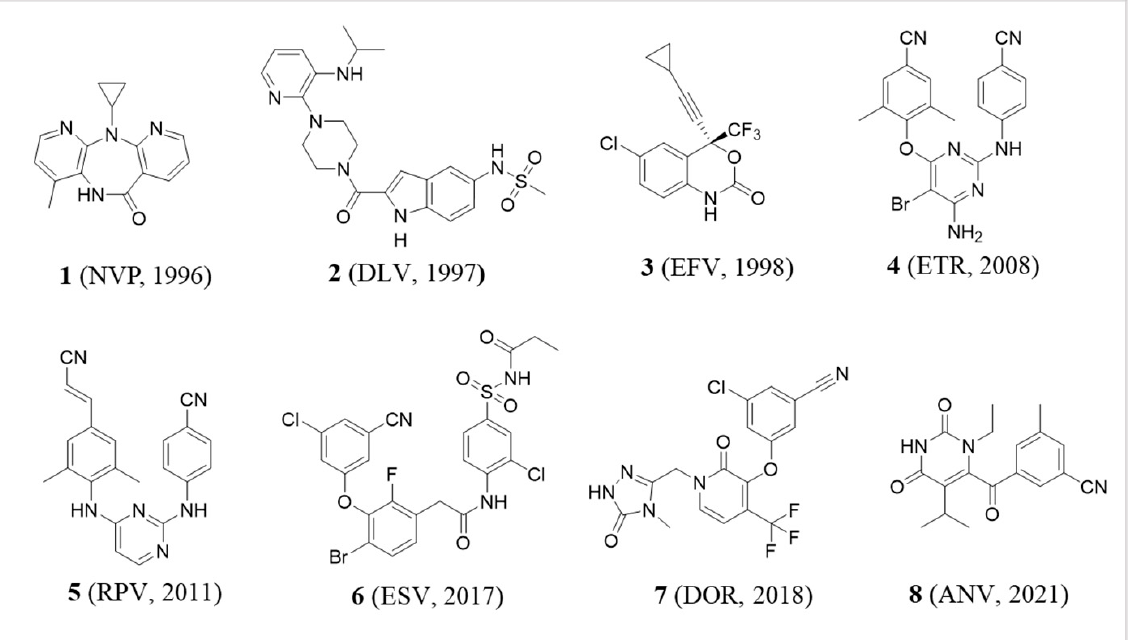
(Figure 2): an aminobenzonitrile moiety (A-ring, right wing), a central pyrimidine ring (B-ring) and the NH linker which form two hydrogen bonds with the backbone of